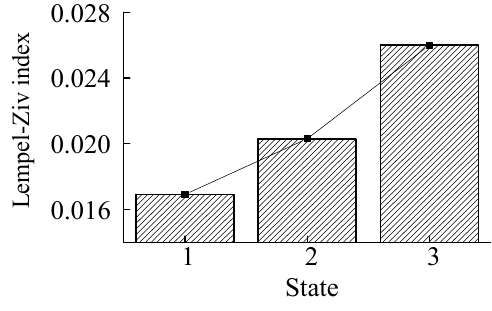
Figure 26. Complexity in different states.